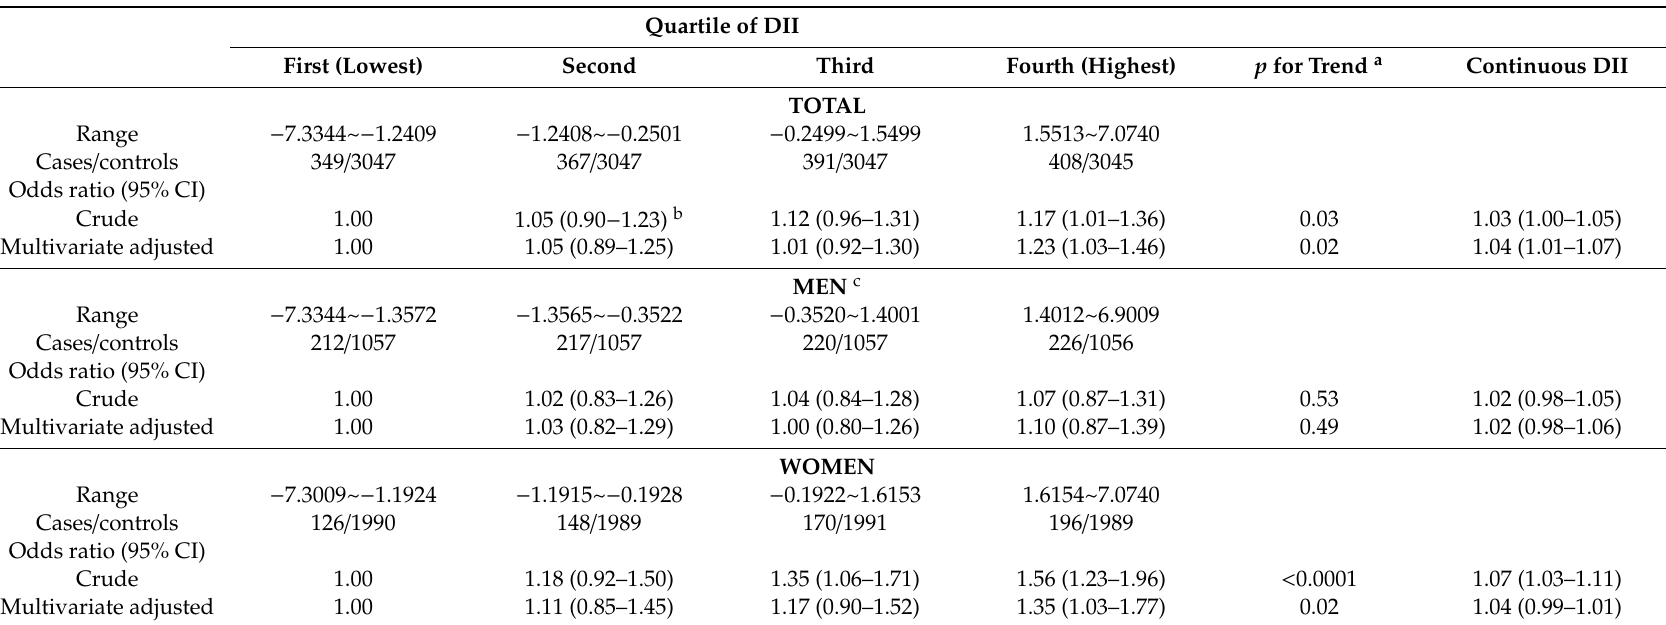
Table 2. Odds ratios (ORs) for hyperuricemia and corresponding 95% CI by quartile of DII scores in KoGES_CAVAS